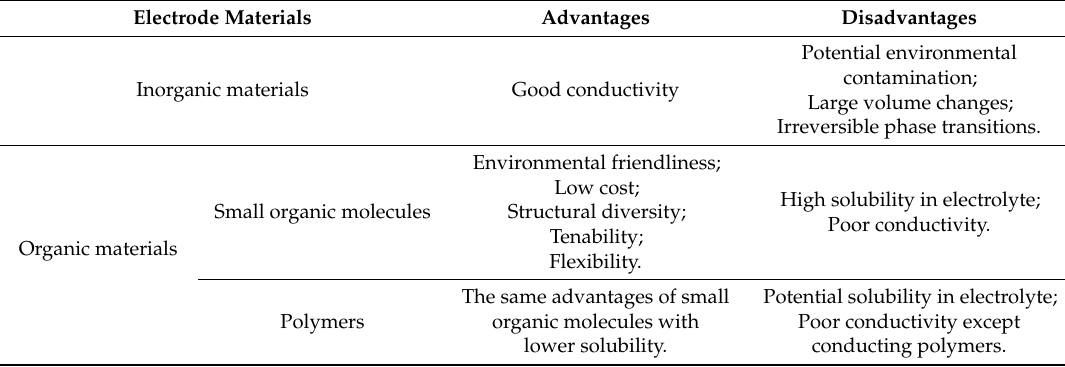
Table 1. Comparison of electrode materials for sodium-ion